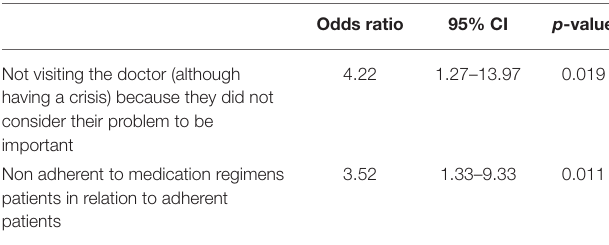
TABLE 2 | Significant relations between demographic (and other characteristics) and patients’ compliance to follow up.